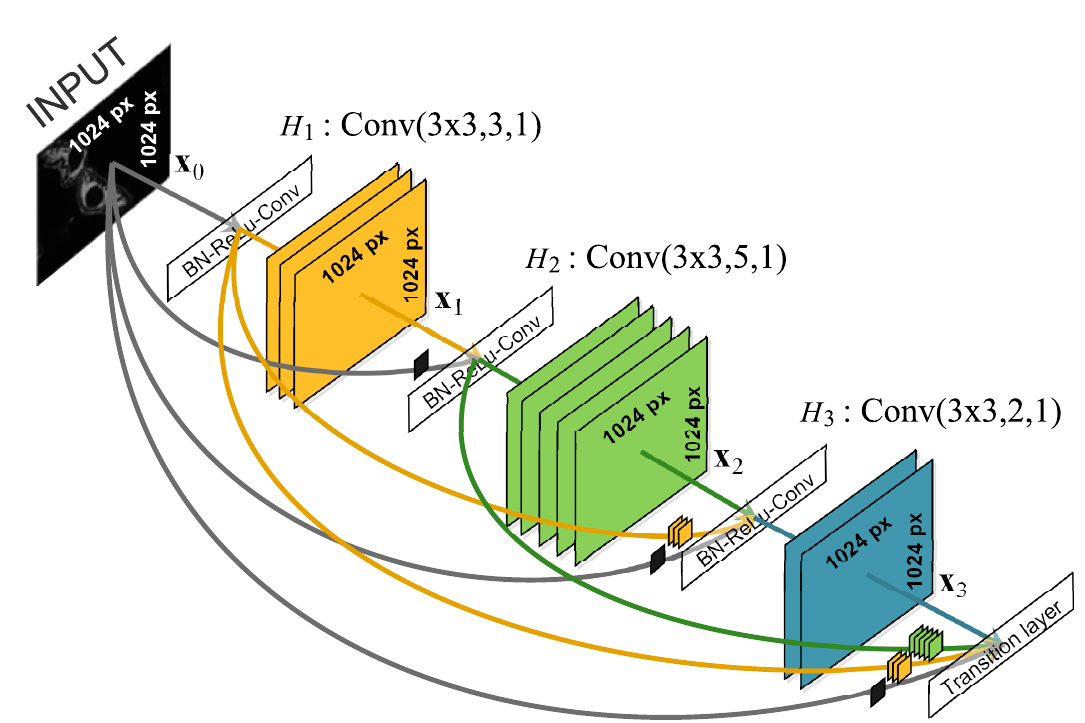
Fig 4. Layout of a general dense block. A dense block consists of d layers where the layers are connected using concatenation and transformed using non-linear transformations H ( � ). Typically, a transition layer follows a dense block. The figure shows a hypothetical dense block of three layers ( d = 3) which is placed at the input of a network. Non-linear transformations H ( � ) within this block are composite functions which consist of the batch normalization (BN), the rectified linear unit (ReLU) and the convolution (Conv), respectively. At the first, second and third layer, three, five and two convolutional filters ( f 1 = 3, f 2 = 5, f 3 = 2) of height and width 3 × 3 px ( h = w = 3) convolve with stride one (s = 1). The input data of the network x 0 is a confocal microscopy image of resolution 1024 × 1024 px. At the first, second and third layer of the dense block, feature maps x 1 , x 2 and x 3 of depth three, five and two originate, respectively. Spatial resolutions of the feature maps are 1024 × 1024 px. Input of each layer is composed of feature maps that arose on the preceding layers of the dense block, and of the input of the block (the confocal microscopy image x 0 in this case). The block input data and the feature maps are catenated at the input of each